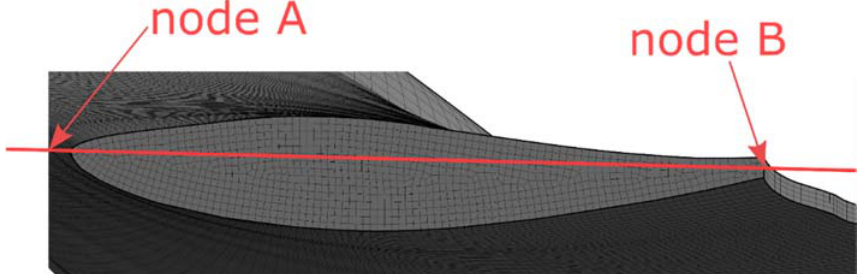
Figure 13. Control line passing through the leading and trailing edge of the blades for determining blade tip twist.